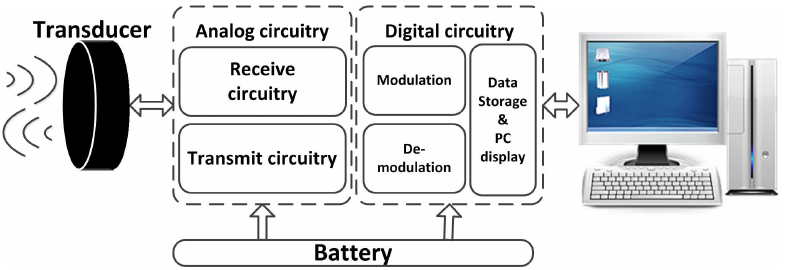
Figure 2. Traditional modem block diagram.